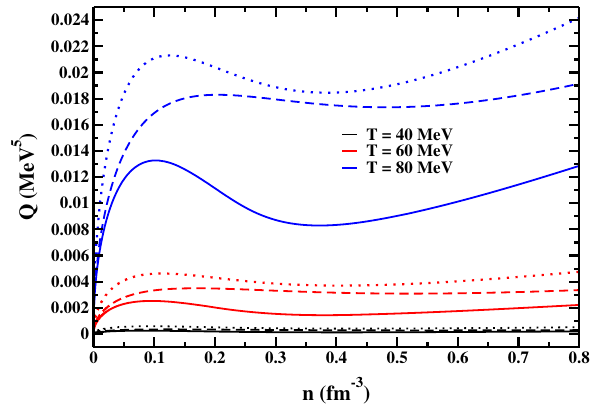
Fig. 9 Neutrino emissivity at different temperatures as a function of nucleon density for NL3 (solid line), G3 (dashed line) and IU-FSU (dotted line) parameter